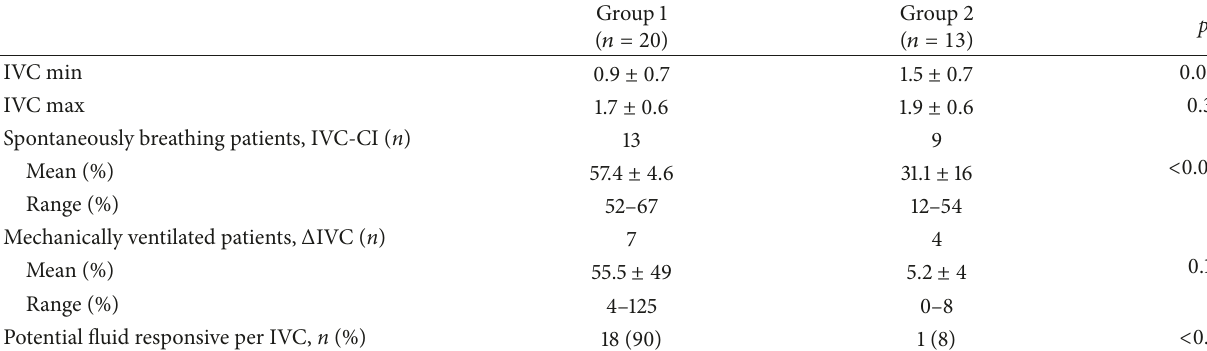
Table 3: Baseline ultrasound data in the 33 patients.